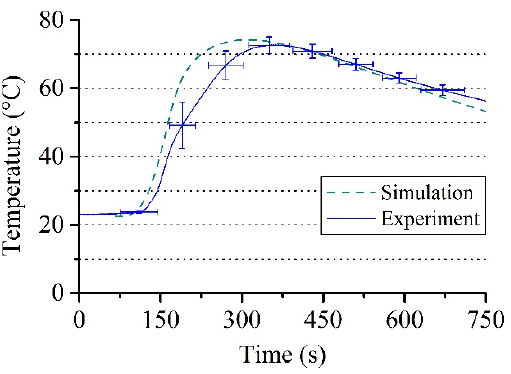
Figure 7 . Averaged temperature data of the experiment at the rod with standard deviation compared with the simulated temperature values.